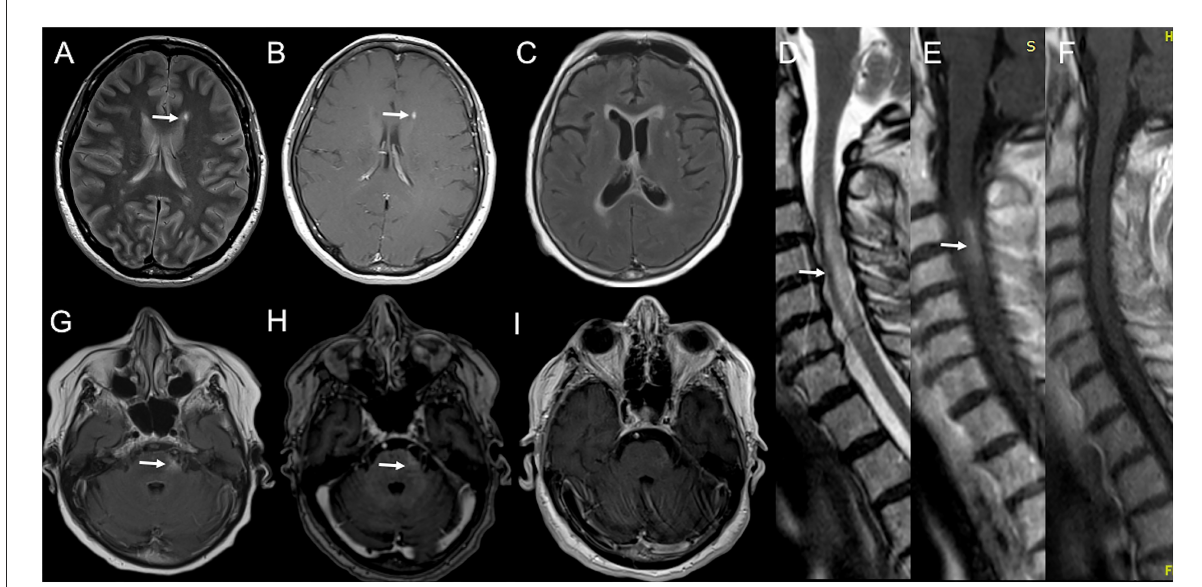
FIGURE3 Serial brain and spinal cord MRI scans in Case 5 (A,B) and Case 6 (C–I) . Case 5: (A) Brain MRI performed 28 days after BNT162b2 first dose, showing a new left lateral periventricular T2-weighted hyperintensity (arrow) with contrast enhancement [ (B) ; arrow]. Case 6: (D) Spinal cord MRI obtained 12 days after BNT162b2 second dose, showing a T2-weighted hyperintensity from C2 to C7 with swelling (arrow) and gadolinium enhancement [ (E) ; arrow]. (G) Brain MRI performed few days later showed a T2-weighted hyperintensity in left lateral pons (arrow) with blurred contrast enhancement [ (H) ; arrow] and confluent supratentorial bilateral periventricular hyperintensities on FLAIR images (C) . (I) 7-days MRI controls revealed the complete resolution of gadolinium enhancement of the left pontine lesion and the volume shrinkage of the cervical lesion with no more contrast enhancement on T1-weighted images (F)